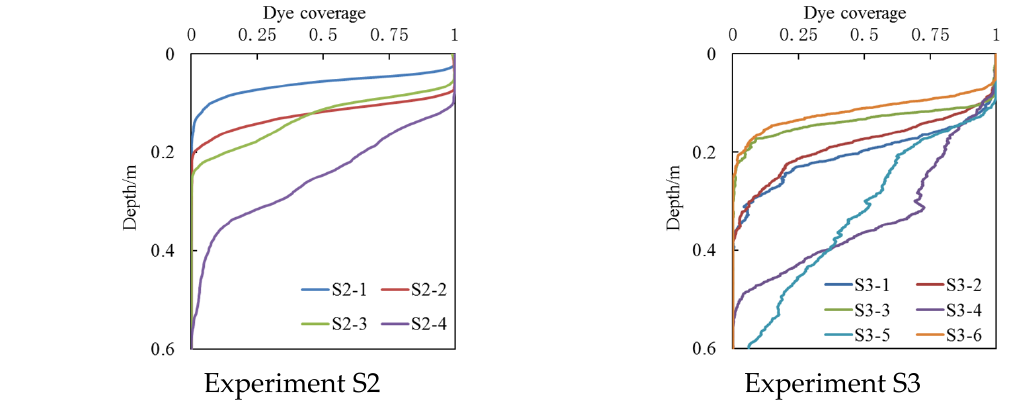
Figure 8. Dye coverage distributions.